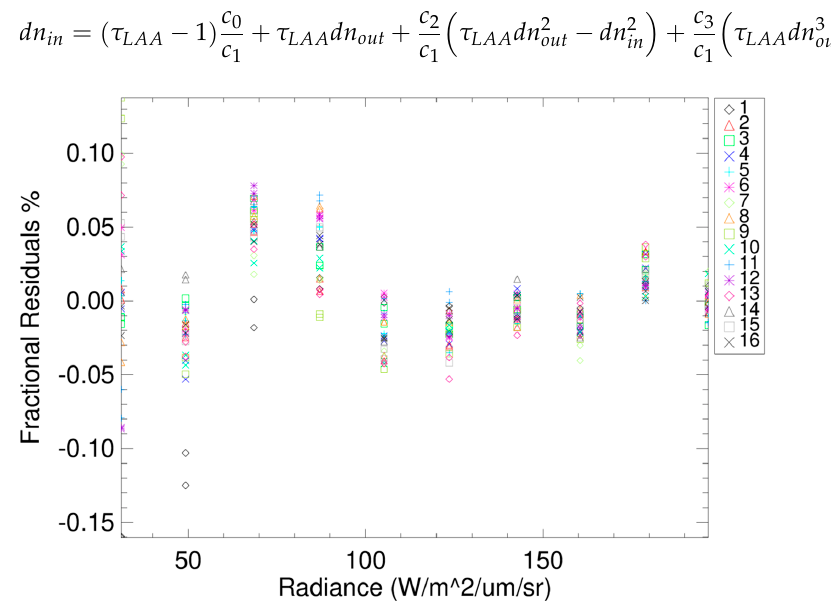
Figure 16. Band M7 low gain fit residuals as a function of SIS100 radiance within the Lmin and Lmax regions for all detectors (colors and symbols).